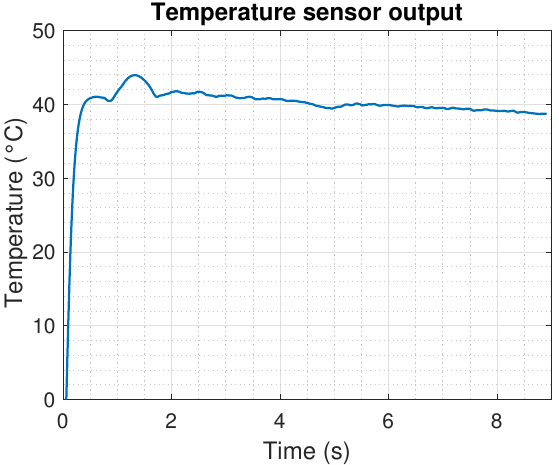
Figure 15. Temperature measurement from the SMA using the thermistor.